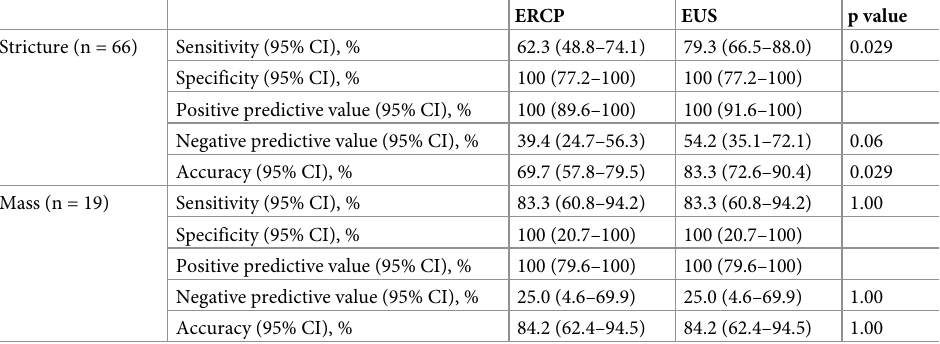
Table 4. Subgroup analysis of diagnostic performance of EUS and ERCP according to the presence of intraductal